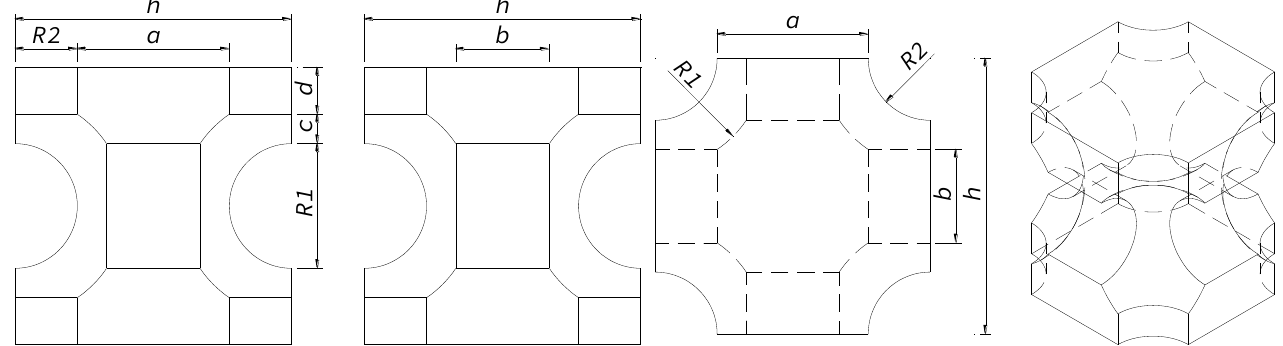
Figure 1. Sketch of the new artificial block TB-CUBE.